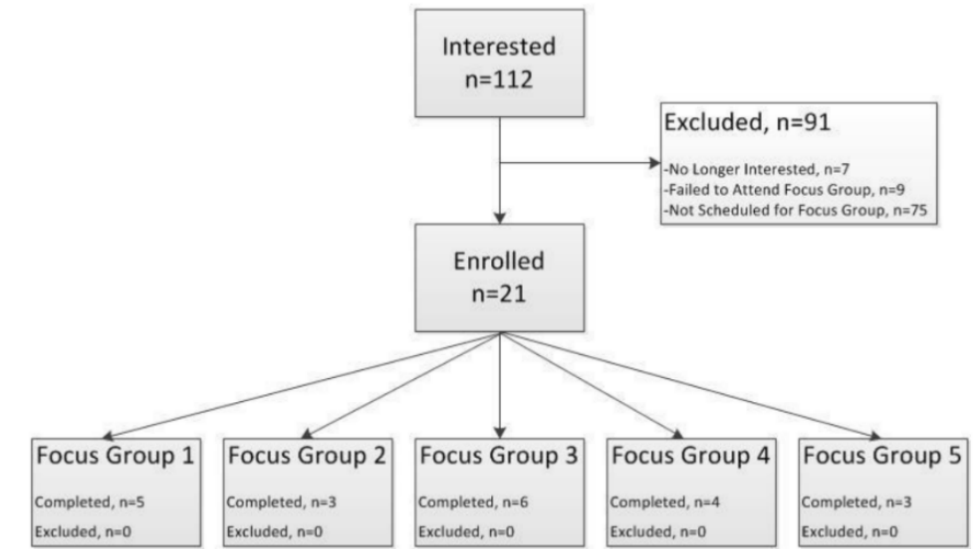
Figure 1. Participatory Research Phase Consort Diagram .